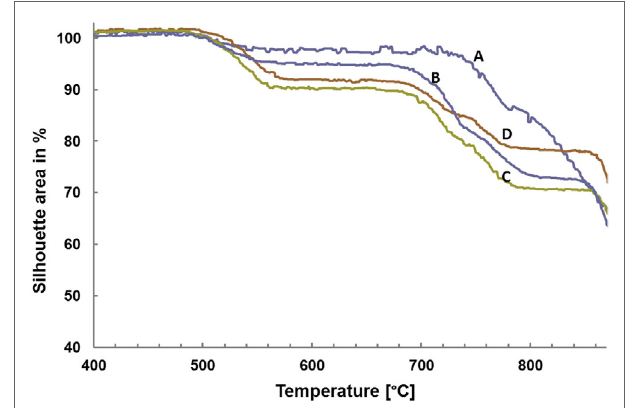
FigUre 2 | sintering behavior of the glass powders determined by high temperature microscopy .